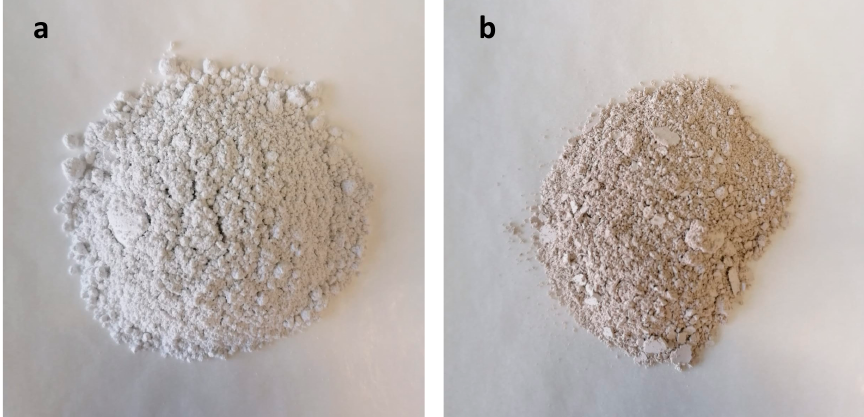
Figure 1. Pictures of the calcium phosphate before ( a ) and after soaking in a humic acid solution at 0.1 g mL − 1 ( b ).